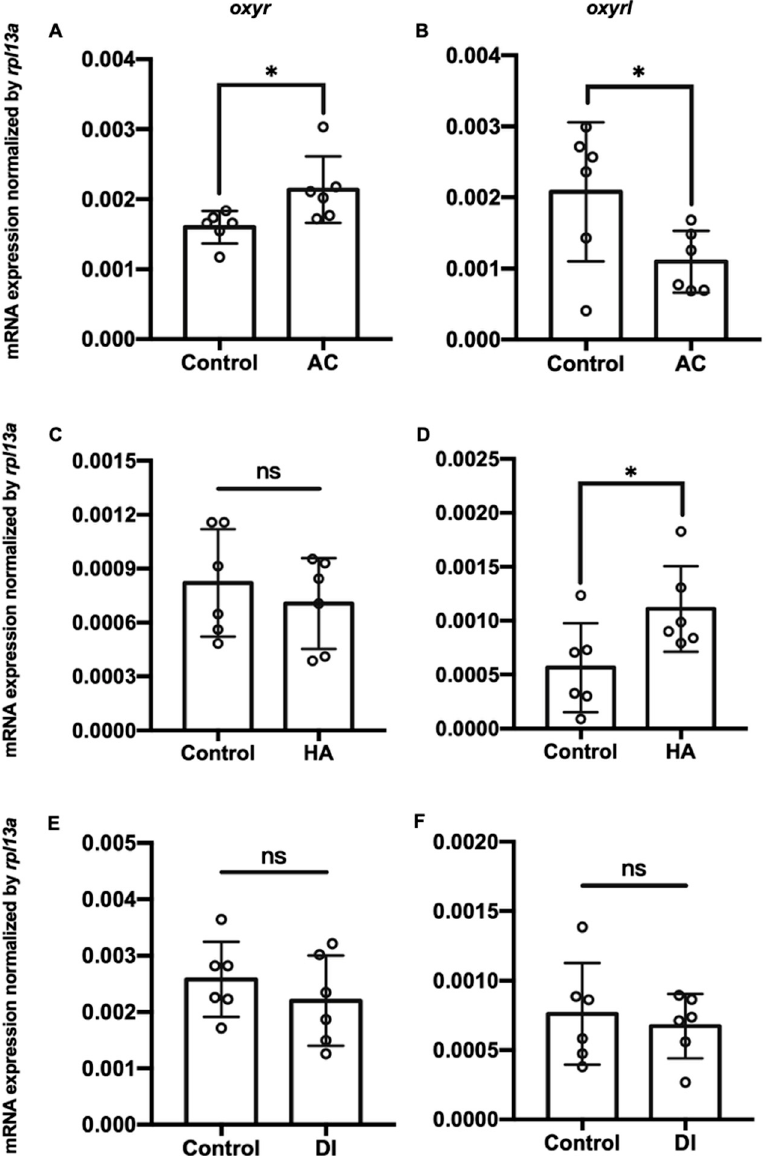
Figure 3. Charts showing mRNA expression of oxyr and oxyrl in the brains of adult zebrafish acclimated to ( A , B ) AC; ( C , D ) HA, or ( E , F ) DI water for 7 days. Rpl13a was used as an internal control to normalize relative expression. Each circle represents the data of one single fish. The asterisks (*) indicate significant differences between the control and treatment groups; ns indicates that no significant difference was found between the control and treatment groups. Values are means ± SD ( n = 6, p < 0.05, (Student’s t -test)).